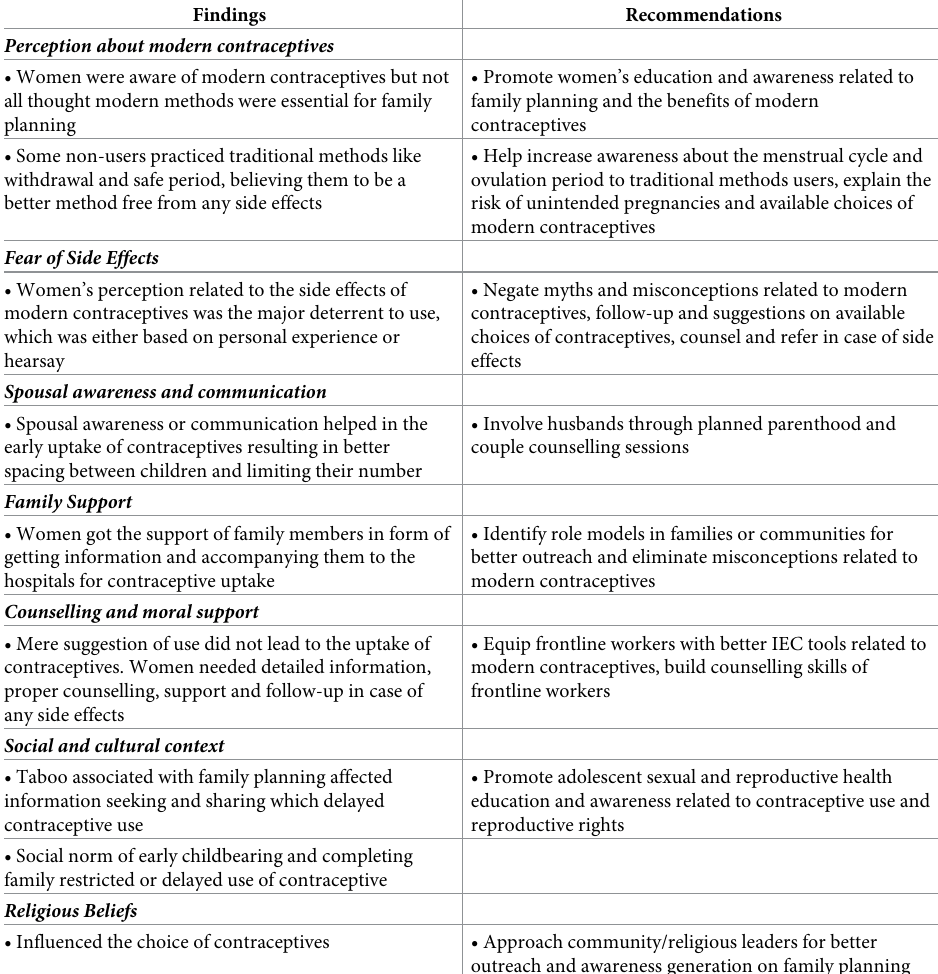
Table 5. Key recommendations.